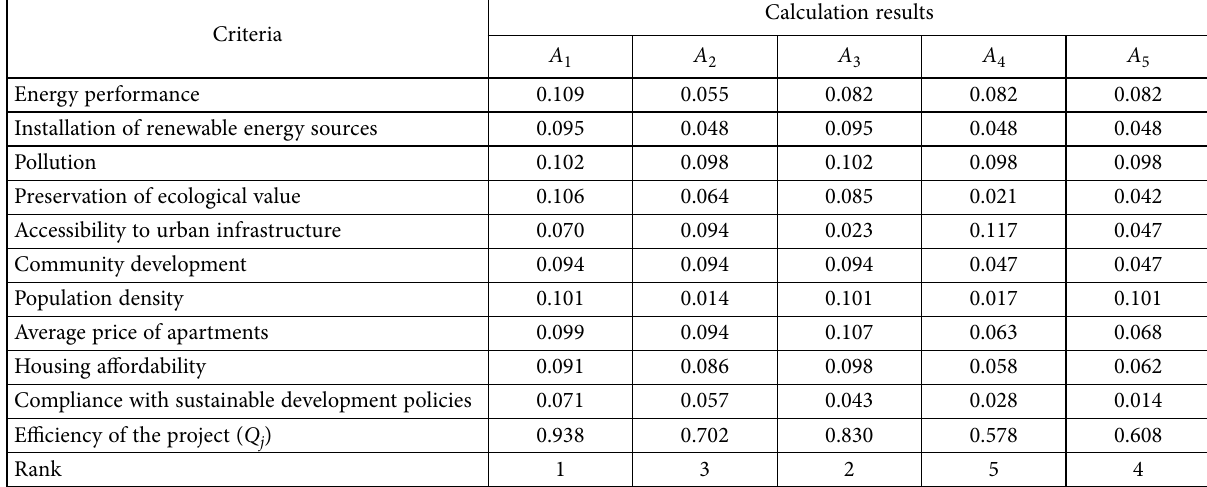
Table 5. Multiple criteria assessment results (SAW